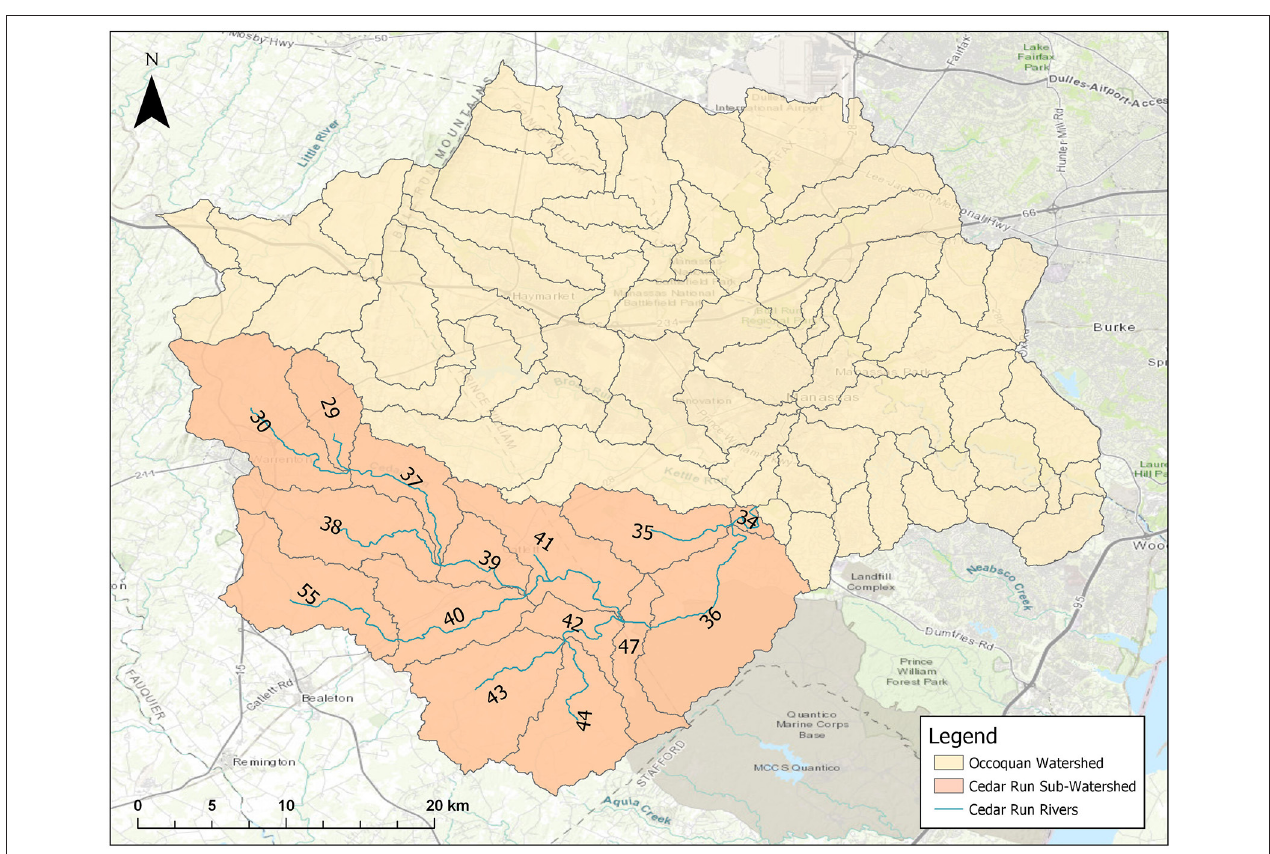
FIGURE 1 | Occoquan Watershed divided into segments with numbered segments representing Cedar Run Sub-watershed.